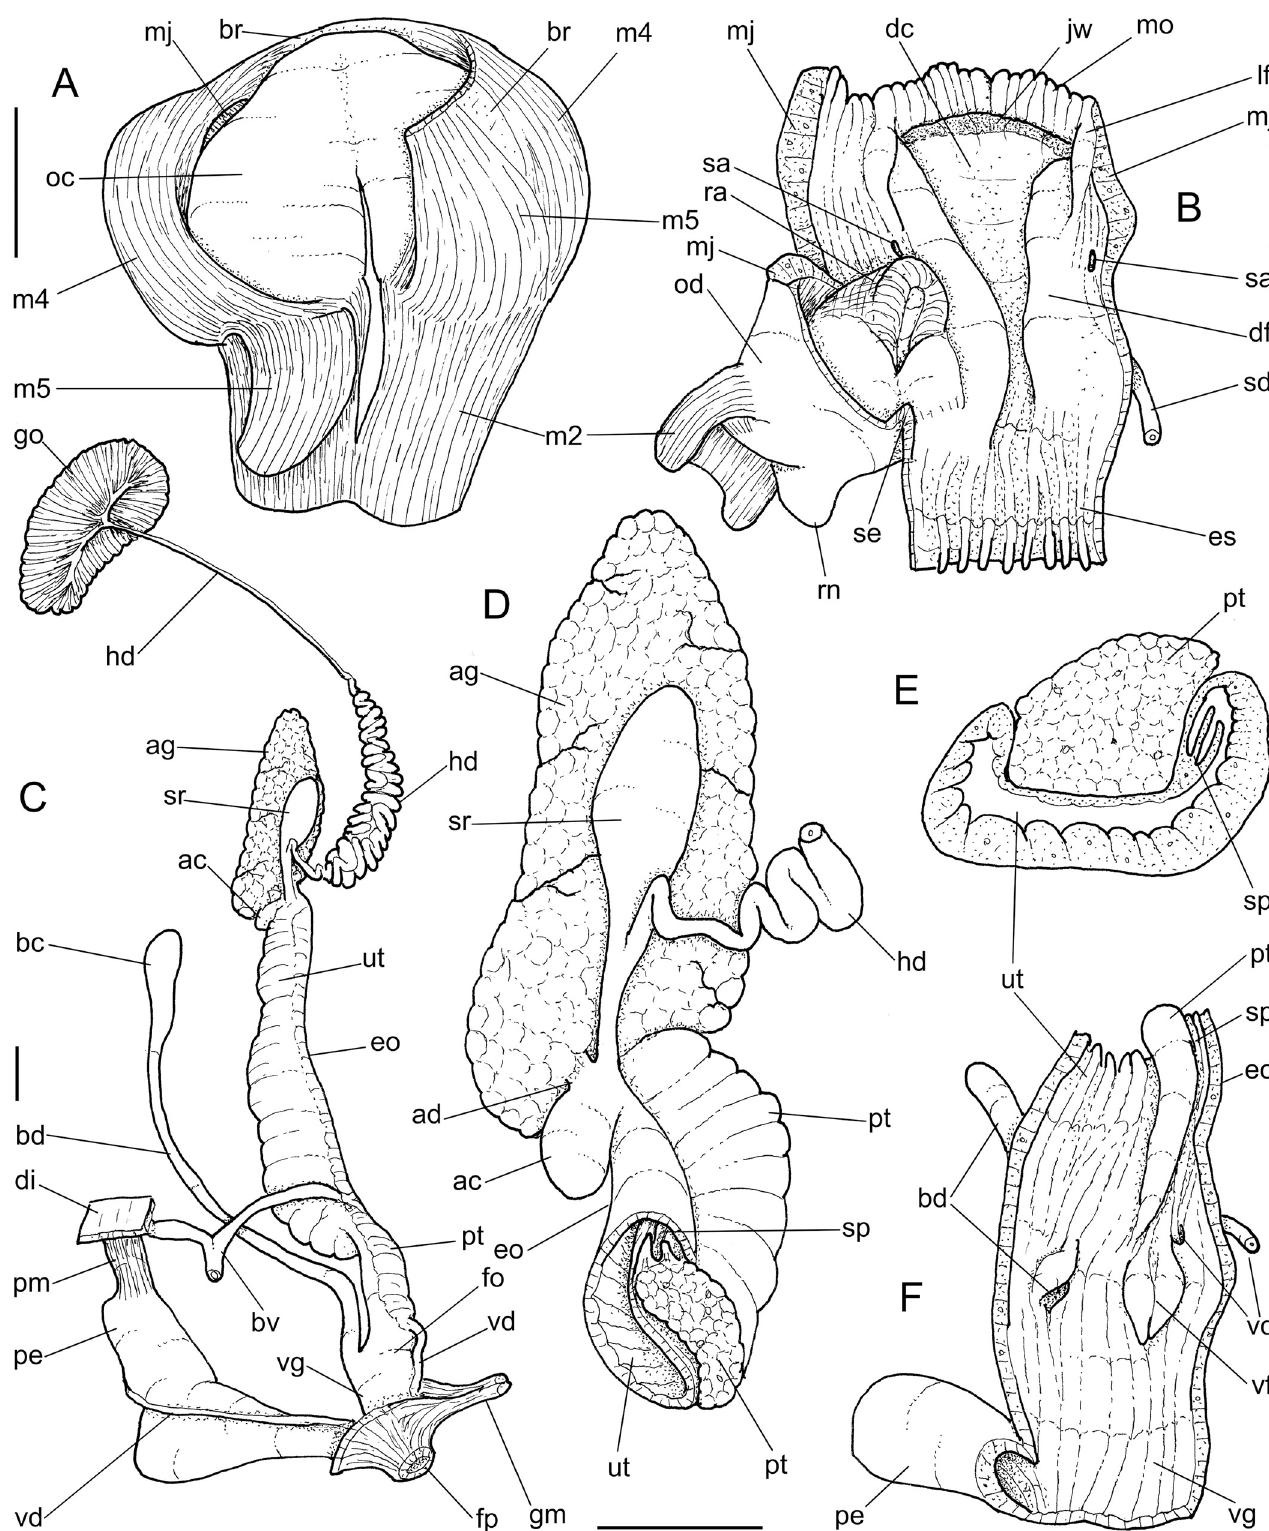
Fig 23. Catracca uhlei , anatomy. (A) Odontophore, dorsal view, superficial layer of muscles and structures removed, left muscles deflected. (B) Buccal mass, ventral view, sectioned longitudinally, odontophore deflected to left. (C) Genital system, mostly ventral view. (D) Middle region of genital system isolated. (E)